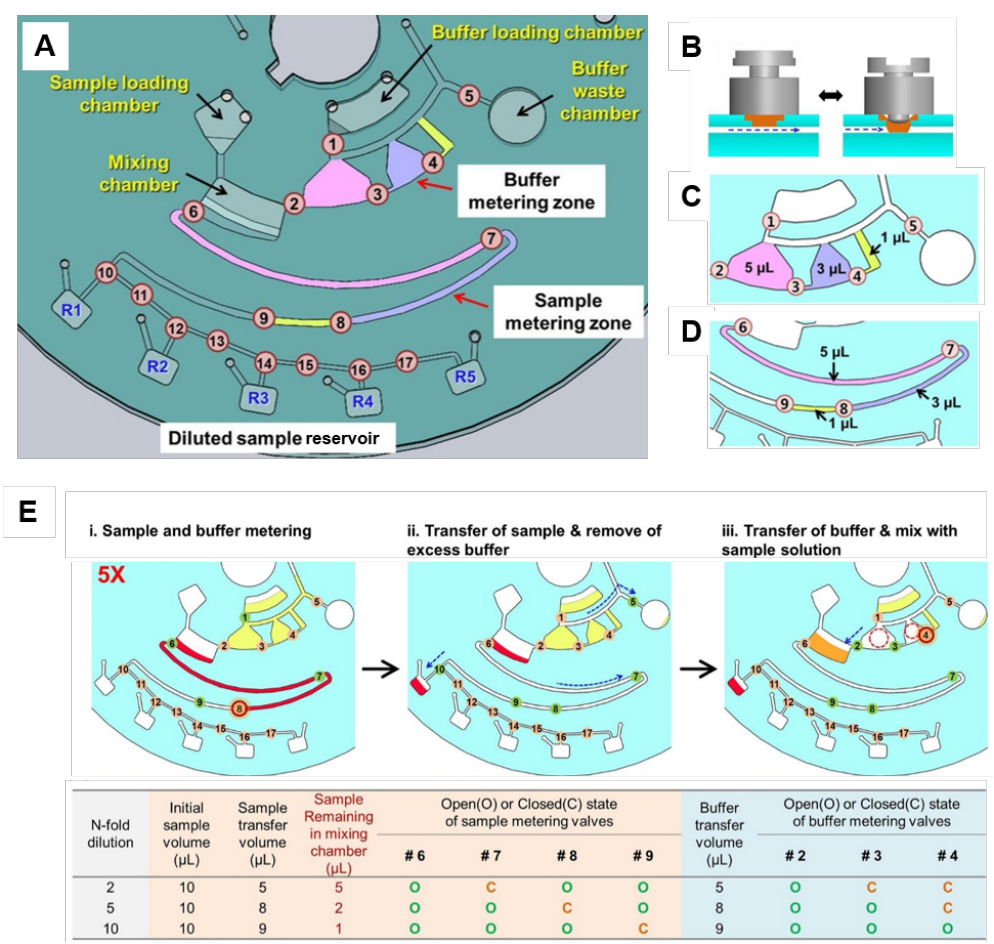
Figure 8. ( A ) Disc design for serial dilution consisting of sample and buffer loading chambers, mixing chamber and buffer waste chamber, two metering zones (for sample and buffer), five collecting reservoirs (R1–R5) for the diluted samples and seventeen ID valves (numbered circles). ( B ) A reversible ID valve composed of a diaphragm (orange) embedded on a top layer and 3D printed valve actuator (gray). Simple push and twist actions open and close the channel. Detailed buffer ( C ) and sample ( D ) metering zones. ( E ) 5-fold dilution steps: (i) in the buffer metering zone, a total of 9 µL is metered keeping V1 opened while V2, V3, V4, and V5 are closed. At the sample metering zone, V6 and V7 are opened while V8 is closed, totaling 8 µL metered; (ii) at the sample metering zone, V6 is closed and the metered liquid within the channel is sent to R1 (V7, V8, V9, and V10 are open while V11 is closed). At the buffer metering zone, V1, V2, V3, and V4 are closed and V5 is opened to send the excess to the waste chamber; (iii) 8 µL buffer is delivered (just V2 and V3 are open while V4 is kept